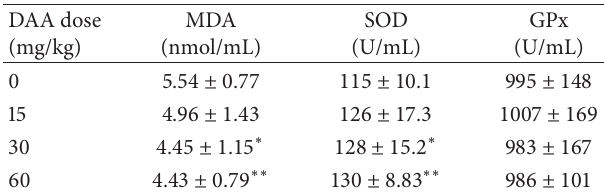
Table 3: Mean ( ± standard deviation) serum MDA concentration and activity of antioxidant enzymes. DAA